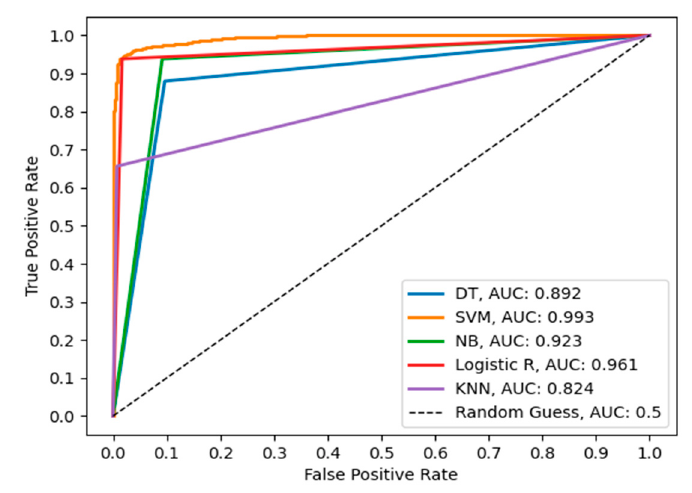
Figure 8. Receiver operating characteristics (ROC) curve comparing performances of the classifiers using 4096 FC1 features of the VGG16 model.